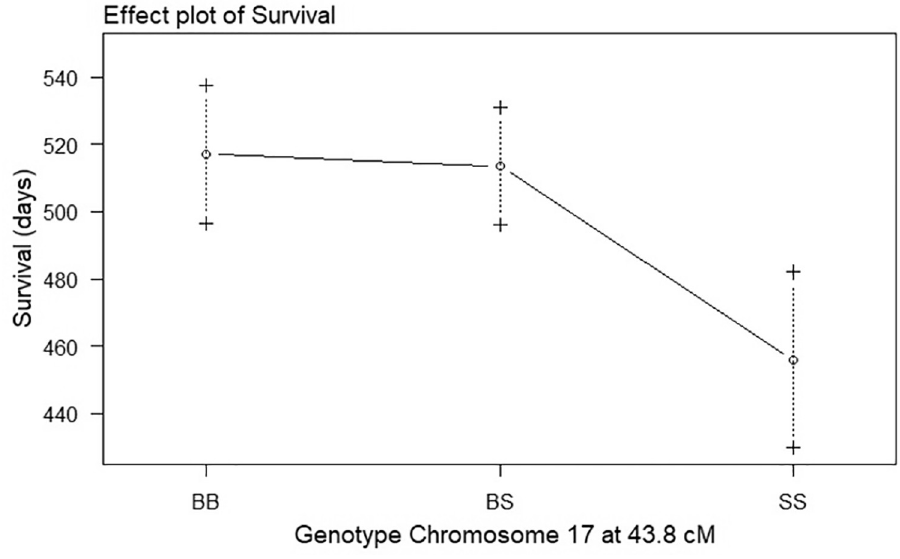
Fig 3. Effect plot of genotype on survival at the chromosome 17 QTL of G59S-hDCTN1 mice. Effect of the genotype at chromosome 17, 43.8 cM on survival. The survival in days is plotted as the mean ± SE. The genotypes are BB for homozygous B6, SS for homozygous SJL and BS for heterozygous B6/SJL.